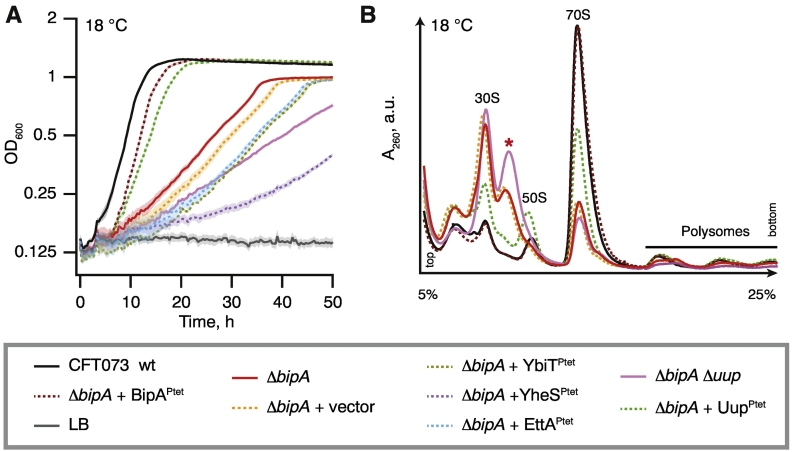
Overexpression of E. coli ABCF Uup suppresses cold sensitivity and ribosome assembly defects caused by loss of translational GTPase BipA. Growth (A) and sucrose gradient polysome analysis (B) of CFT073 wild-type, isogenic ΔbipA and ΔbipAΔuup, as well as CFT073 ΔbipA transformed with low-copy pSC vector expressing either BipA or ABCFs EttA, Uup, YheS and YbiT under control of constitutive promoter Ptet. All experiments were performed in filtered LB at 18 °C, and data are presented as geometric means ± standard deviation (n = 3).